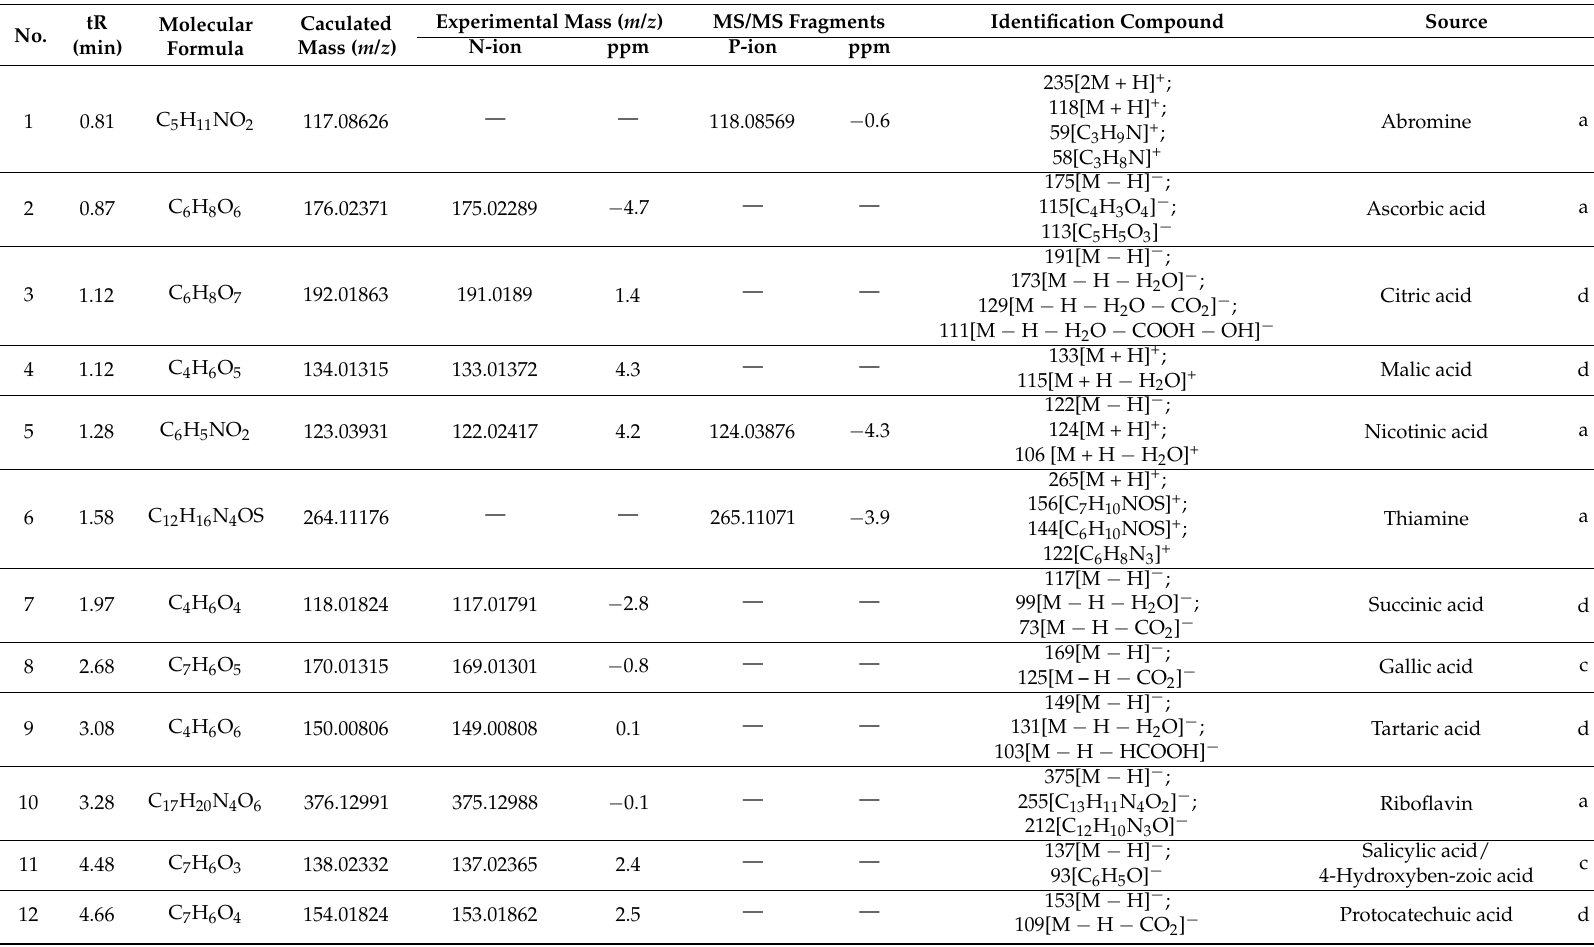
Table 1. Identification of the chemical constituents of WZYZW by